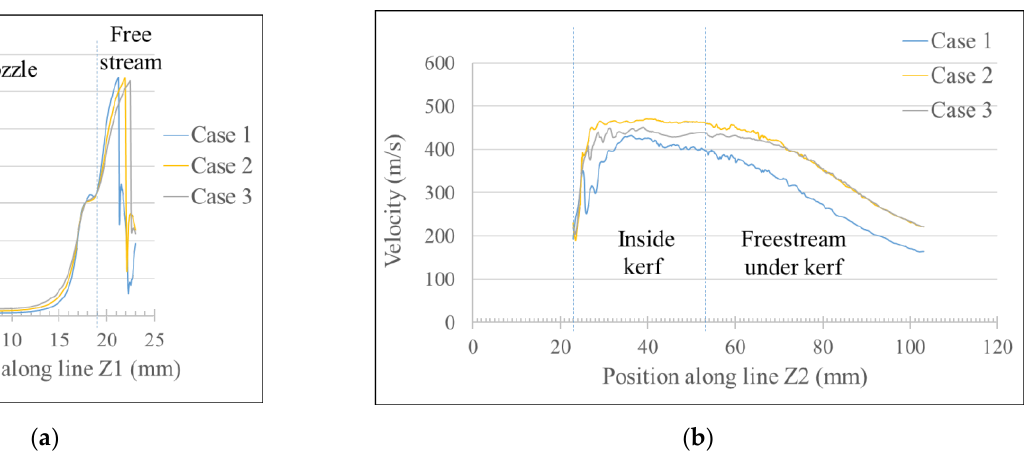
Figure 15. Velocity distribution curve for various nozzle configurations in kerf slot (l offset = 3 mm): ( a ) along line Z1 and ( b ) along line Z2.